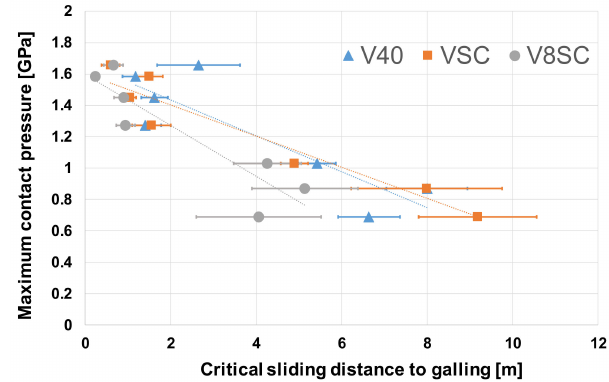
Figure 7. The summary of the galling tests for the tested tool